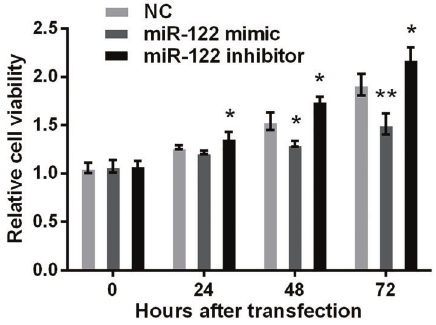
Figure 2. Viability of transfected mouse cardiomyocytes. Mouse cardiomyocytes were transfected with miR-122 mimic, miR-122 inhibitor or the negative control (NC). MTT assay was performed at 0, 24, 48, and 72 h post-transfection and absorbance at 570 nm